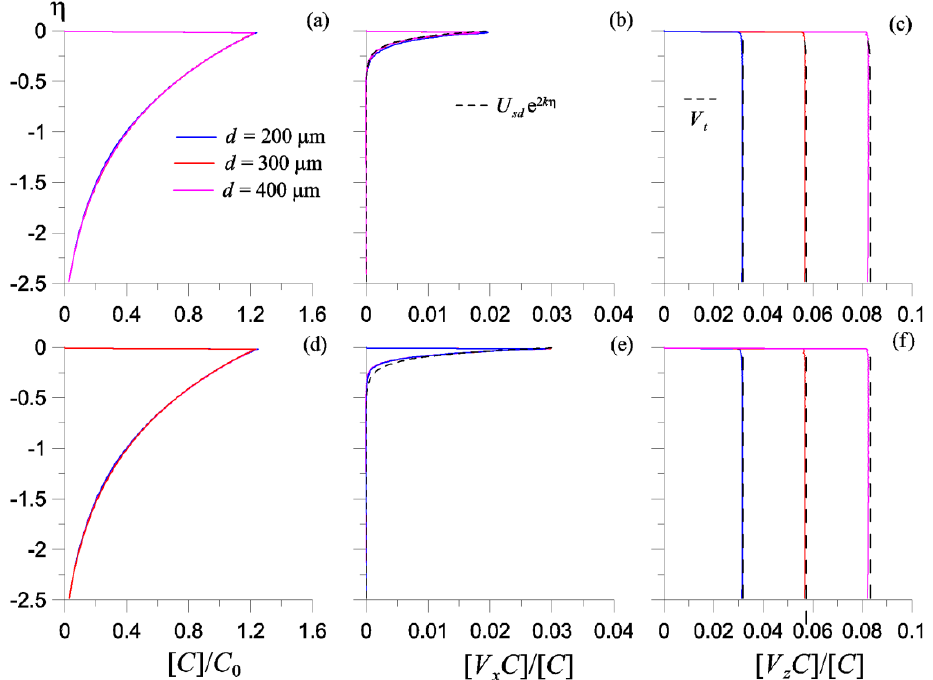
Figure 7. Profiles of mean bubble concentration, [ C ], ( a , d ); and horizontal ( b , e ) and vertical ( c , f ) components of the concentration (void fraction) fluxes, [ CV x ] and [ CV z ], normalized with [ C ], obtained in DNS for different bubble size, d , (200 µm, blue color; 300 µm, red; and 400 µm, magenta). Top panels ( a – c ) are for the cases without the wind-induced surface drift ( U d = 0), and bottom panels ( d – f ) are for finite U d . Parameterizations for the fluxes in panels ( b , c ) and ( e , f ), Equations (31) and (32), are shown in dotted and dashed line, respectively. Wave slope ka = 0.2.